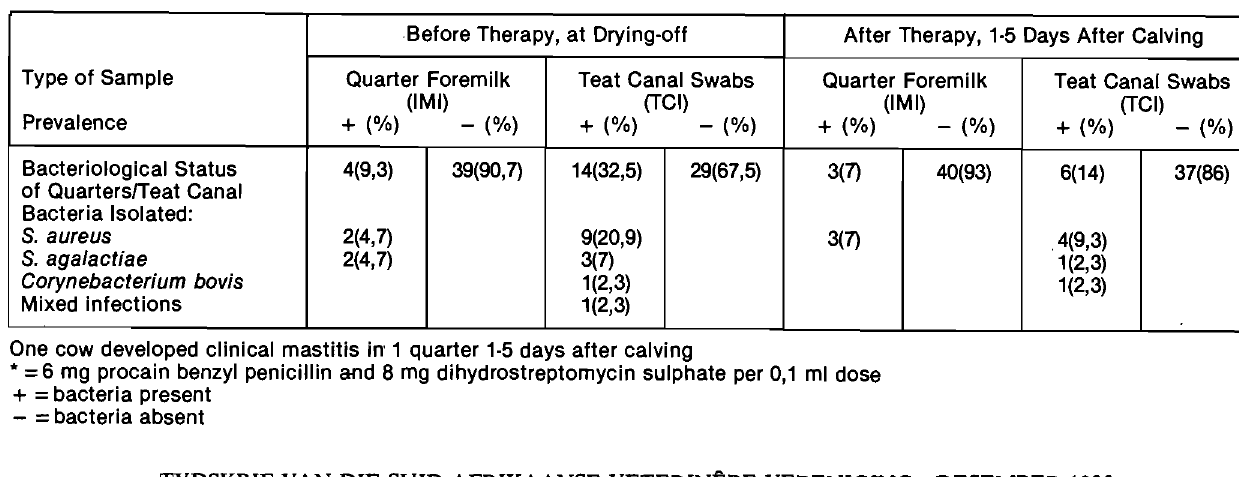
Table 1: Group 1 cows: Effect of dry cow teat canal therapy with 0,1 ml pen-strep * mixture on intramammary (1M I) and teat canal infections (Tel) of the same 43 quarters .Before Therapy, at Drying-off After Therapy, 1·5 Days After Calving Type of Sample Quarter